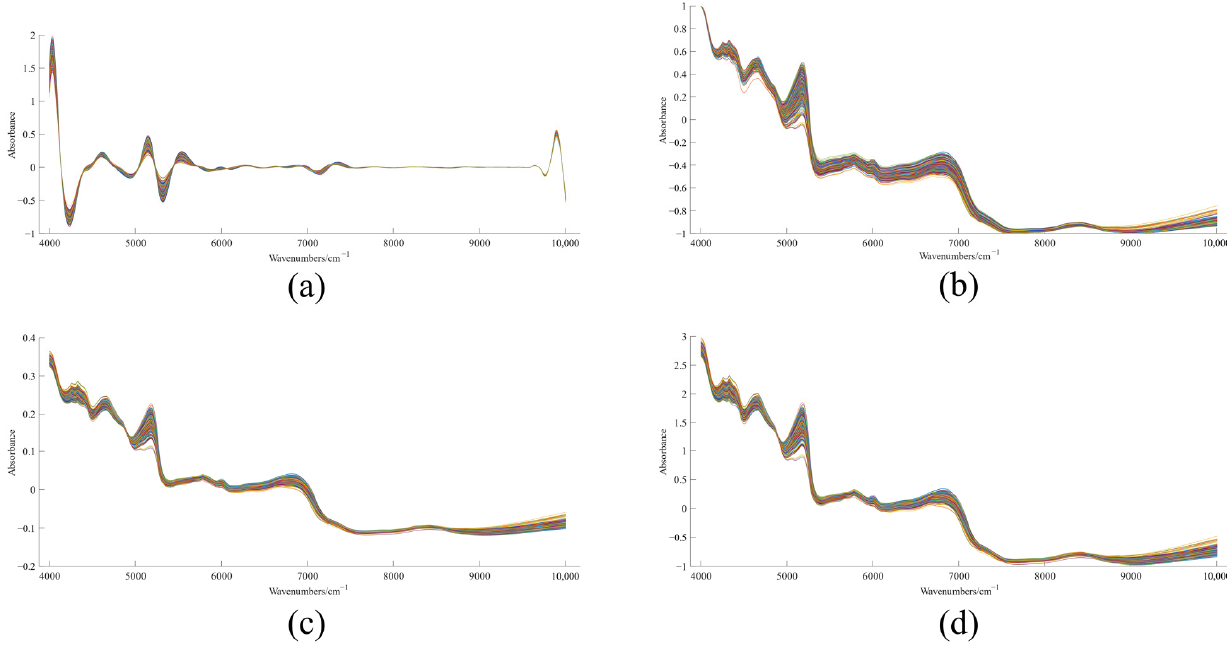
Figure 3. The effects of different spectral pretreatment methods. ( a ) CWT, ( b ) Minmax, ( c ) MSC, ( d ) SNV.